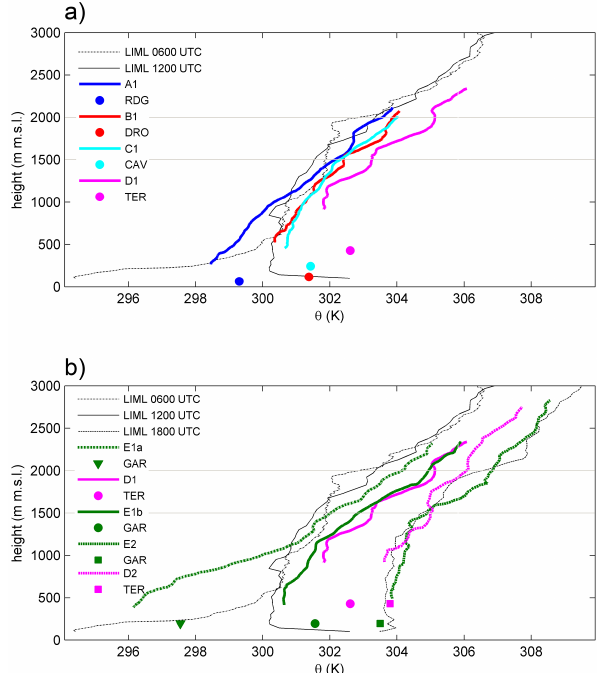
Figure 6. As in Fig. 5 but for w